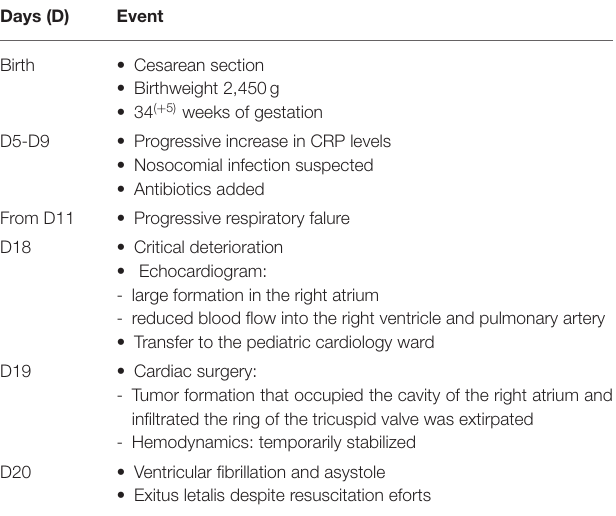
TABLE 1 | Timeline of